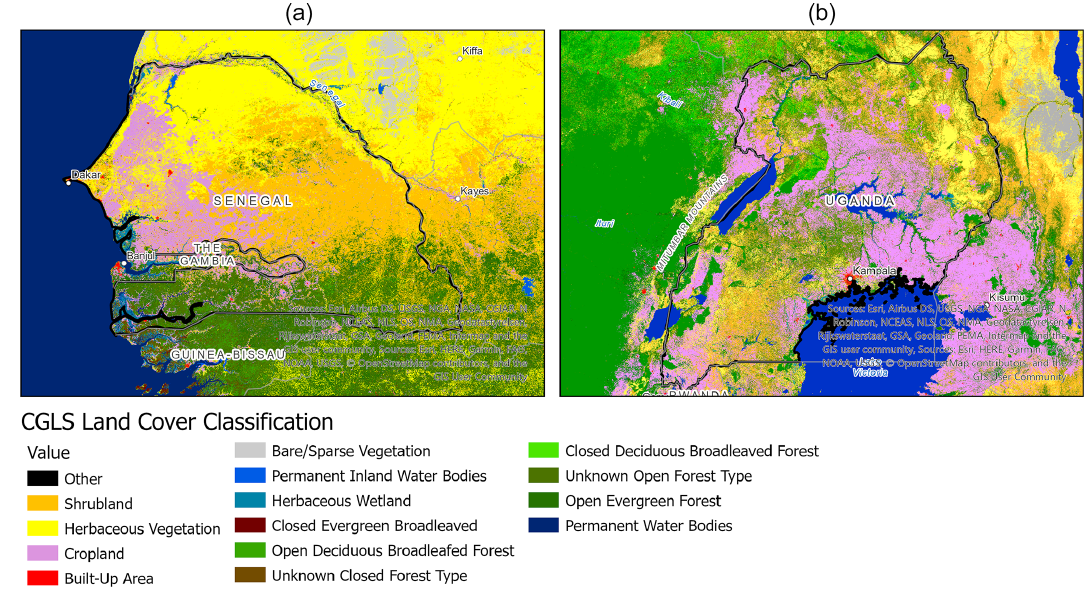
Figure 5. (a) Land cover classification map of Uganda from 2019. (b) Land cover classification map of Senegal from 2017. Data are obtained from the Copernicus Global Land Service Africa Land Cover Maps, which are derived from PROBA-V satellite observations (Buchhorn et al.,